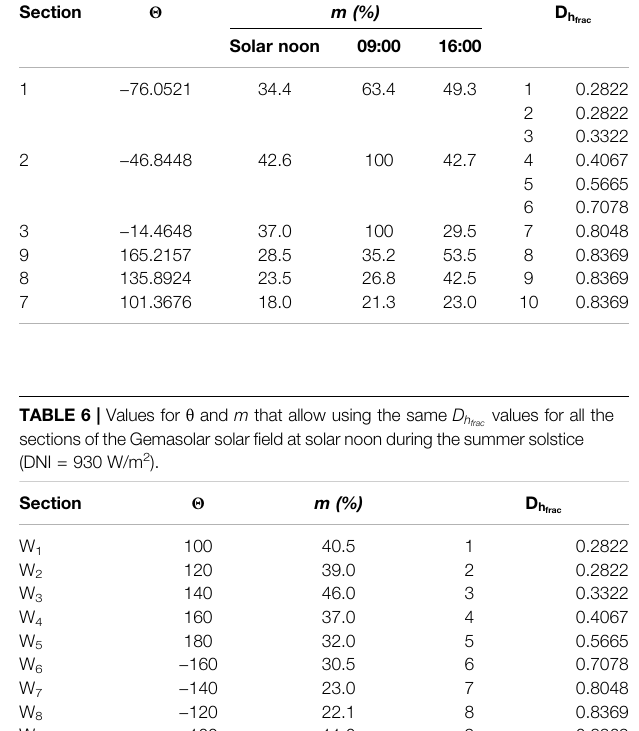
TABLE 5 | Values for θ and m that allow using the same D h sections. Section